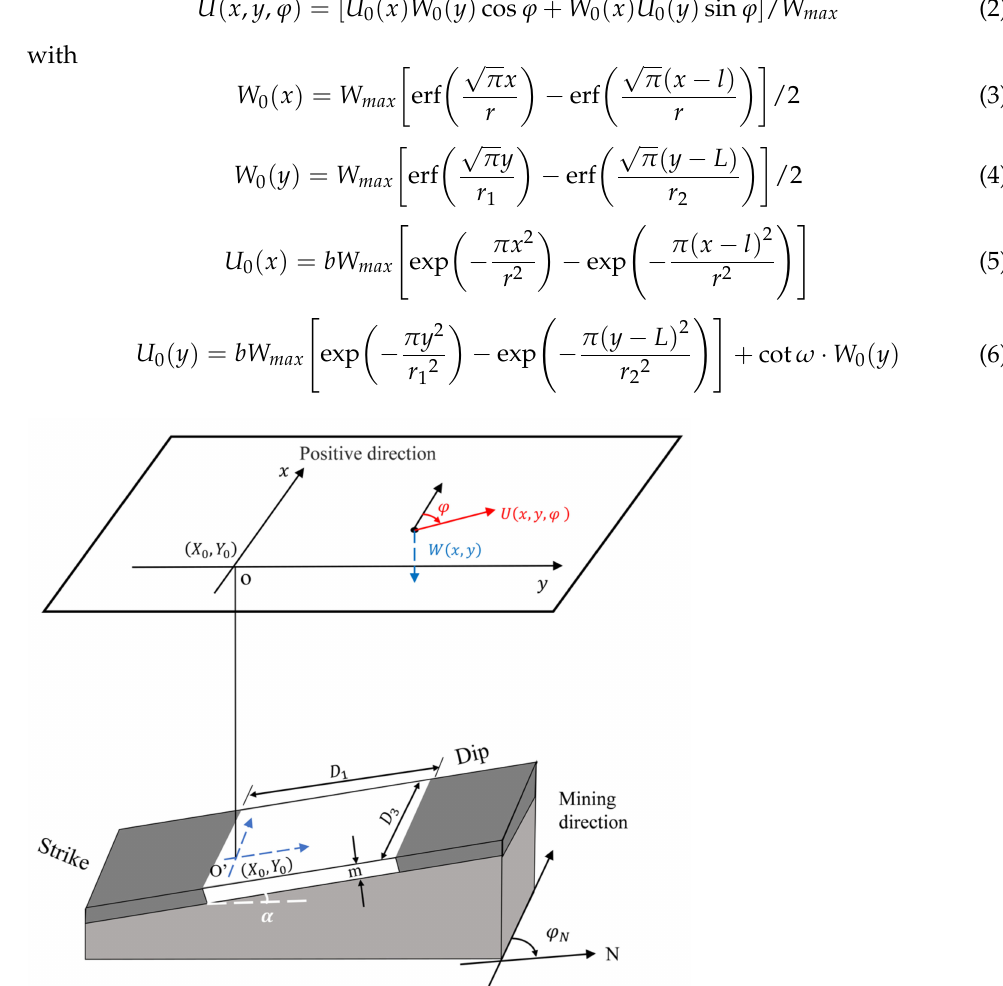
Figure 1. Underground goaf (white cuboid) and 3D coordinate system of the PIM model. In Equations (1) and (2), W max = mq cos α is the maximum subsidence value of the ground; q is the subsidence factor; W 0 ( x ) and W 0 ( y ) are the vertical subsidence on the main section of the strike and dip directions, respectively (see Figure 2); U 0 ( x ) and U 0 ( y ) are the horizontal deformations on the main section of the strike and dip directions, respectively. Furthermore, l = D 3 − S 3 − S 4 and L = [( D 1 − S 1 − S 2 ) sin ( α + ω )] / sin ω are the calculated boundary length and width of the goaf, where ω (see Figure 2b) is the influence propagation angle of mining, S 3 , S 4 , S 1 , and S 2 (see Figure 2) are the offsets of inflection points in strike-back, strike, down-dip, and up-dip directions. r 1 = H 1 / tan β 1 , r 2 = H 2 / tan β 2 , and r = H / tan β are the main influence radius in down-dip, up-dip and strike directions, respectively, where tan β , tan β 1 , and tan β 2 are the tangents of the major influence angles in the three directions. H (see Figure 2a) is the average mining depth, H 1 and H 2 (see Figure 2b) are the mining depths in down-dip and up-dip directions, and b is the horizontal displacement